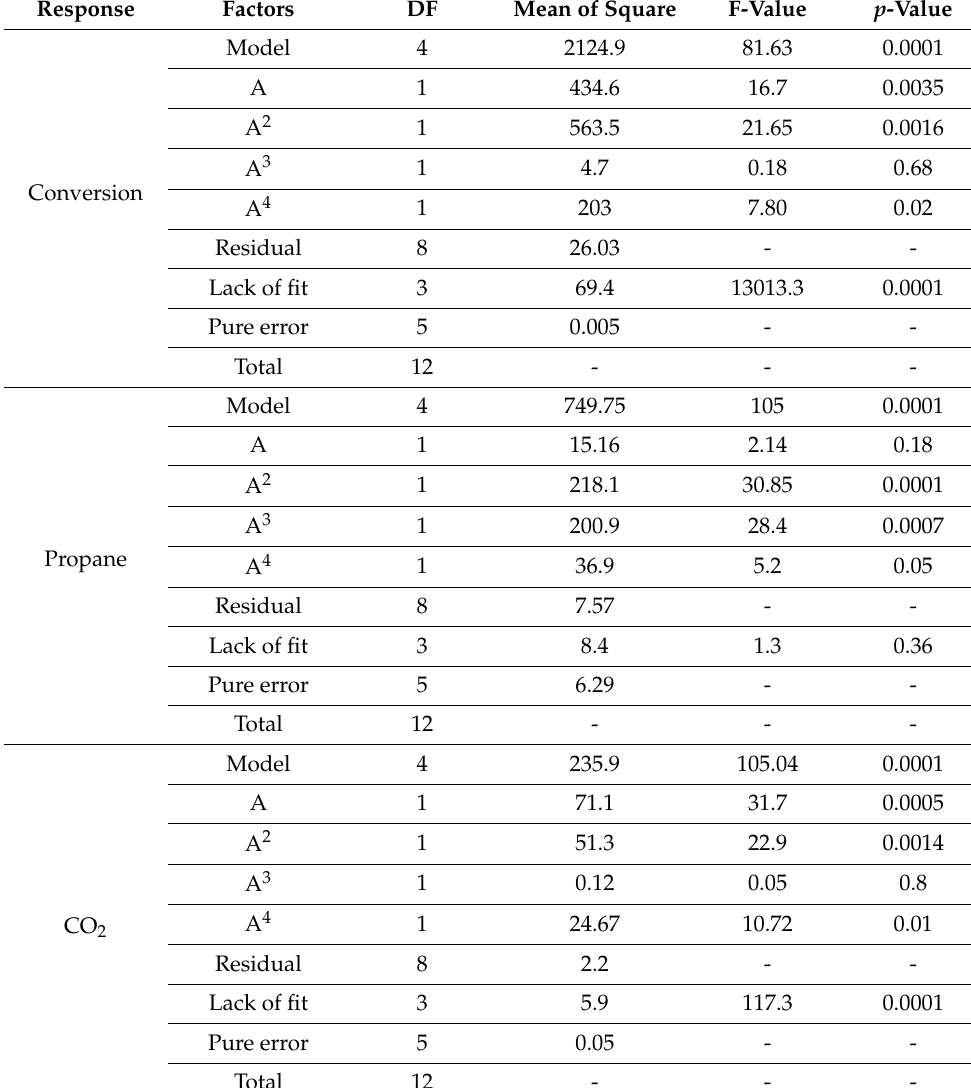
Table 7. ANOVA results for the models for butyric acid conversion and yields of propane and CO 2 under nitrogen gas